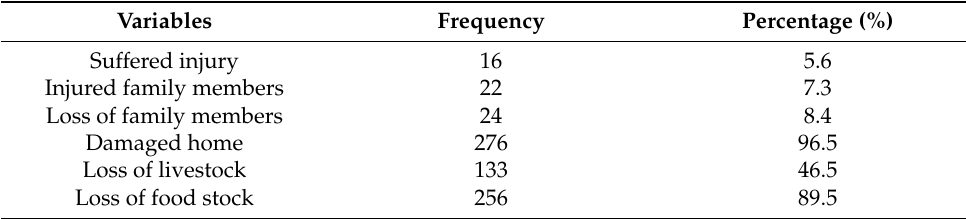
Table 3. Earthquake exposure variables ( n = 286).